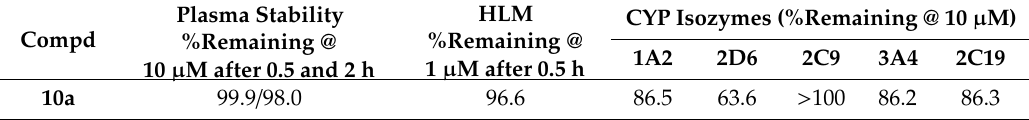
Table 4. The results of plasma stability, microsomal stability, and CYP